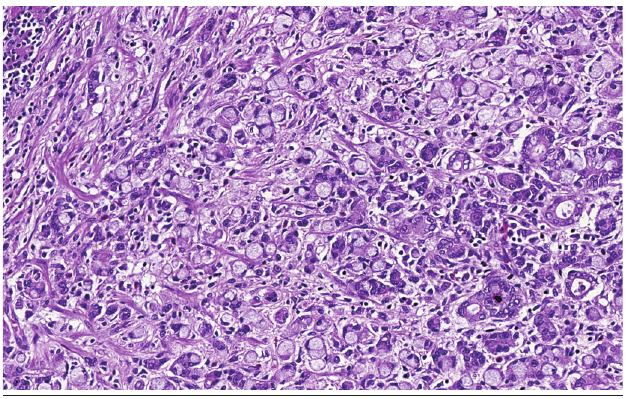
figura 2 – Área representativa AGD selecionada para treinamento da rede neural convolucional com no mínimo 70% da imagem contendo AGD AGD: adenocarcinoma gástrico de tipo